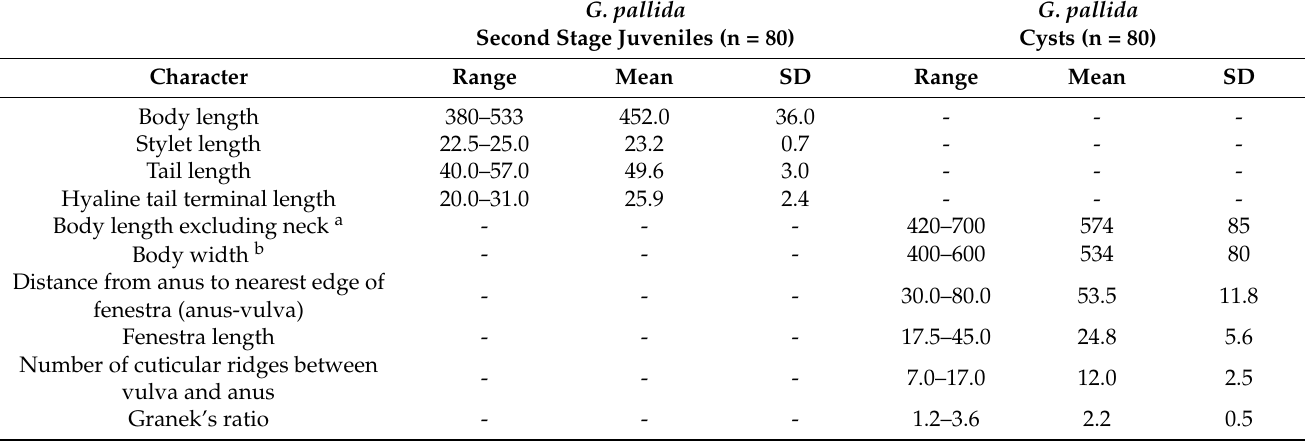
Table 3. Morphometrics of diagnostic characters of second-stage juveniles and cysts of Globodera pallida from Idaho after Skantar et al. [40] (courtesy of Journal of